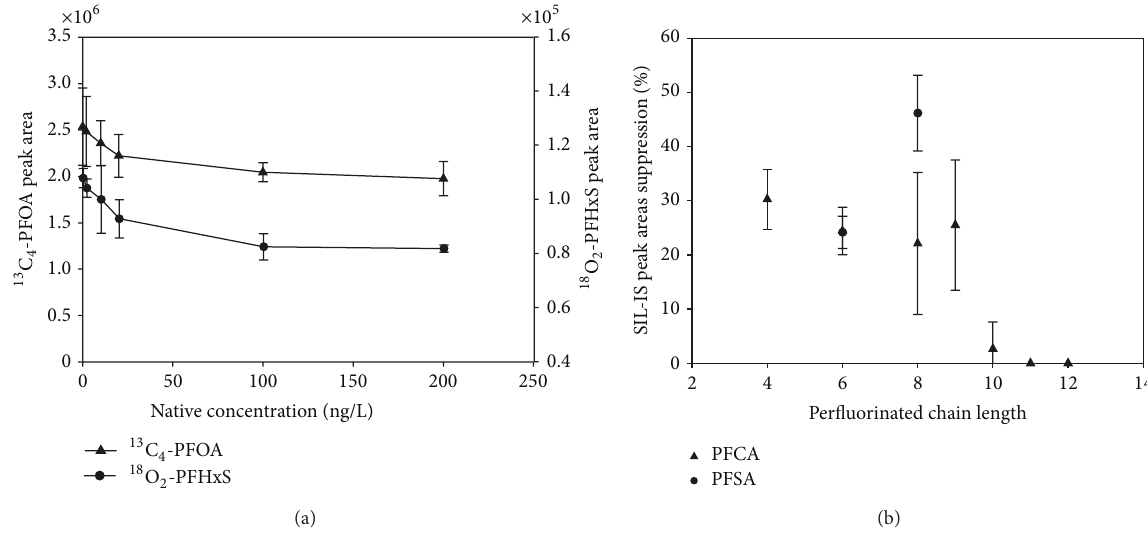
Figure 5: Effect of native concentration on coeluting SIL-IS peak area. (a) Injection in “early gradient” mode of 5 mL of acidified aqueous standards spiked with 100 ng/L of SIL-IS. (b) Extent of suppression of SIL-IS peak area at 100ng/L was calculated as SIL-IS peak area of 0ng/L native standard solution minus SIL-IS peak area of 200 ng/L native standard solution/SIL-IS peak area of 0 ng/L native standard solution X